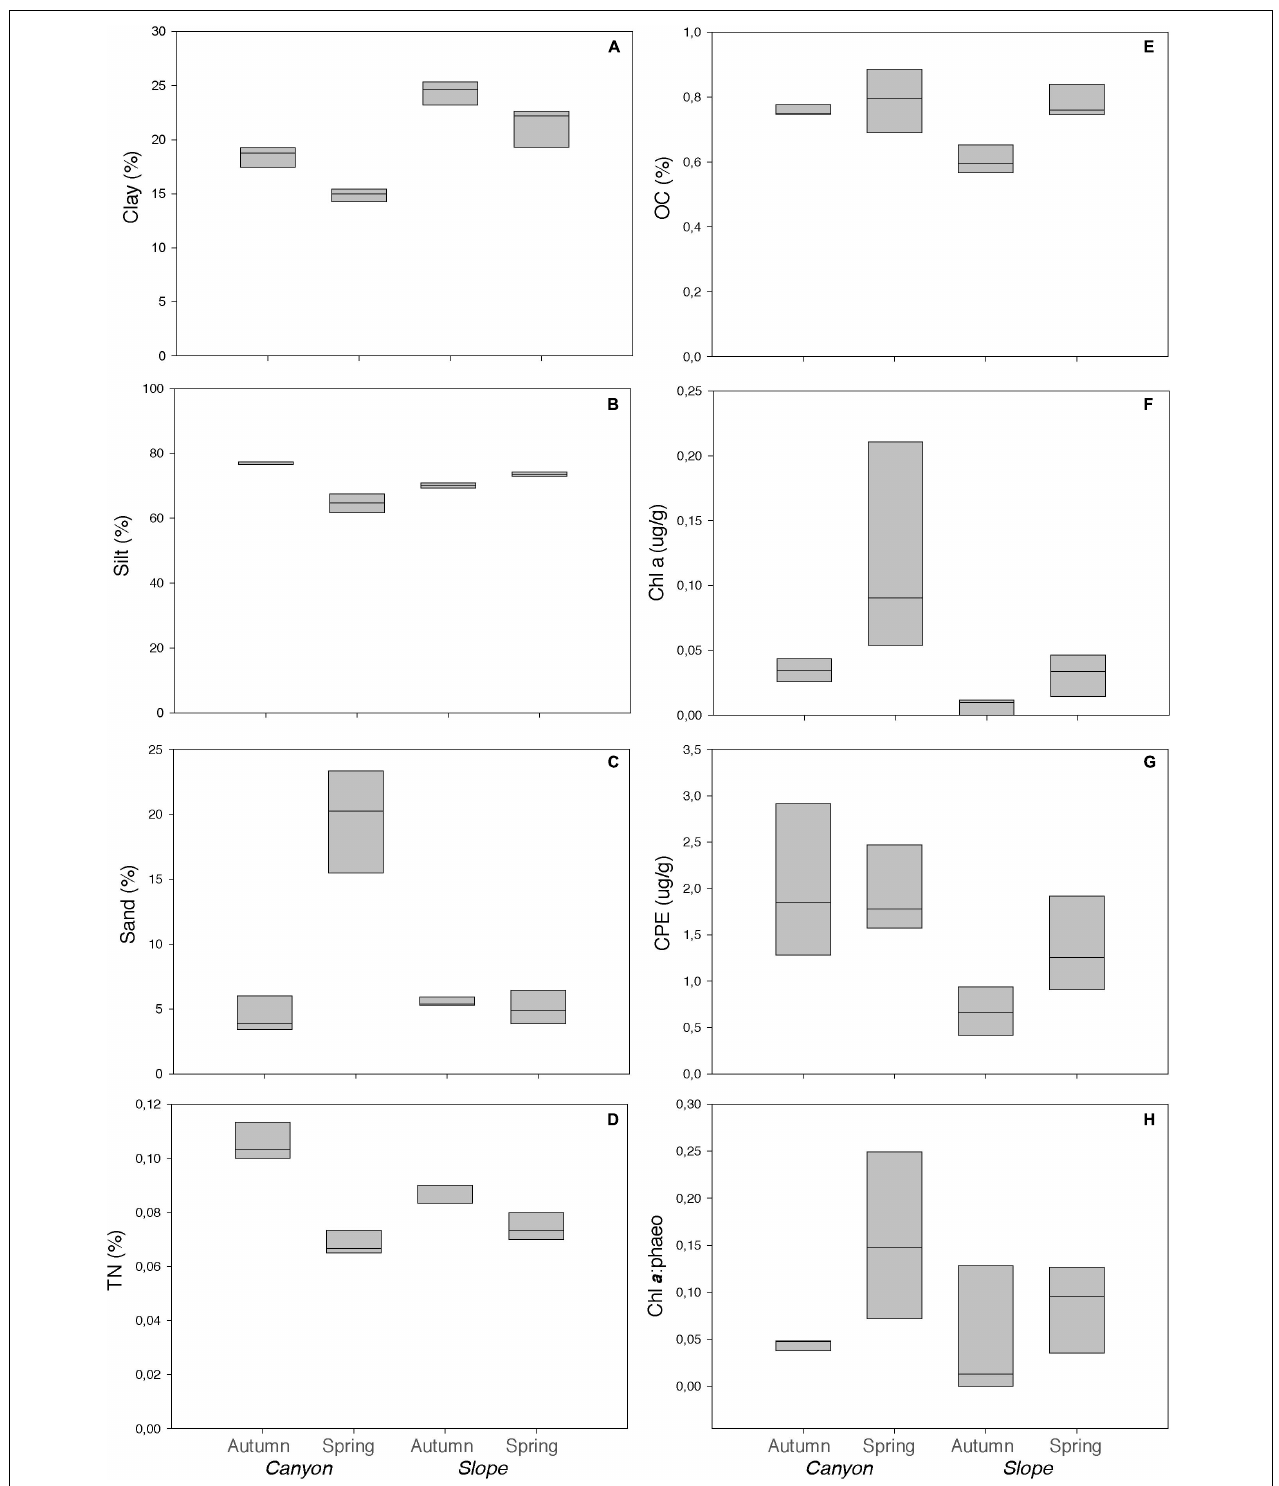
FIGURE 2 | Environmental variables used in this study for canyon (BC) and slope (OS) stations: (A–C) Granulometry (%Clay, %Silt, and %Sand), (D) TN (total nitrogen), (E) OC (organic carbon), (F) Chl a (Chlorophyll a), (G) CPEs (chloroplastic pigment equivalents) and (H) Chl a : phaeo (Chlorophyll a : phaeopigments). Black lines represent the median, and lower box indicates the first quartile and upper box the third quartile. Upper line on the boxes shows the maximum value and lower line the minimum value.